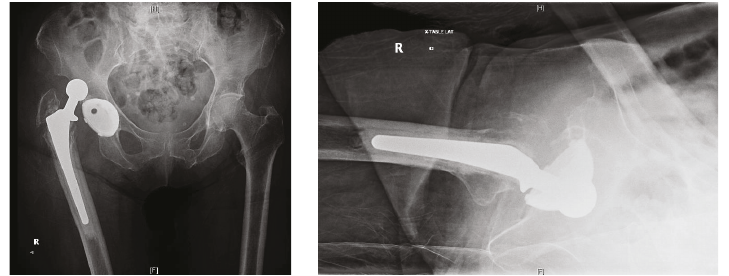
Figure 1: Anteroposterior (AP) pelvis and lateral right hip radiographs showing a posterosuperior dislocation of the right cemented femoral component with associated chronic greater trochanteric periprosthetic fracture and chronic left inferior pubic rami fracture.